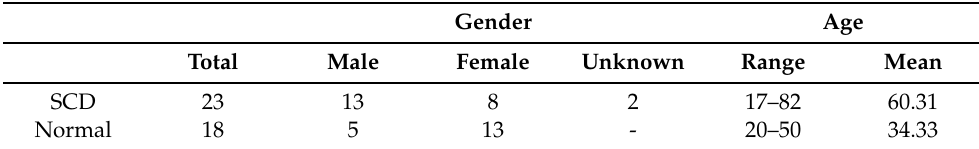
Table 1. Demographic information from the MIT/BIH-NSR and MIT/BIH-SCDH databases [23,24].